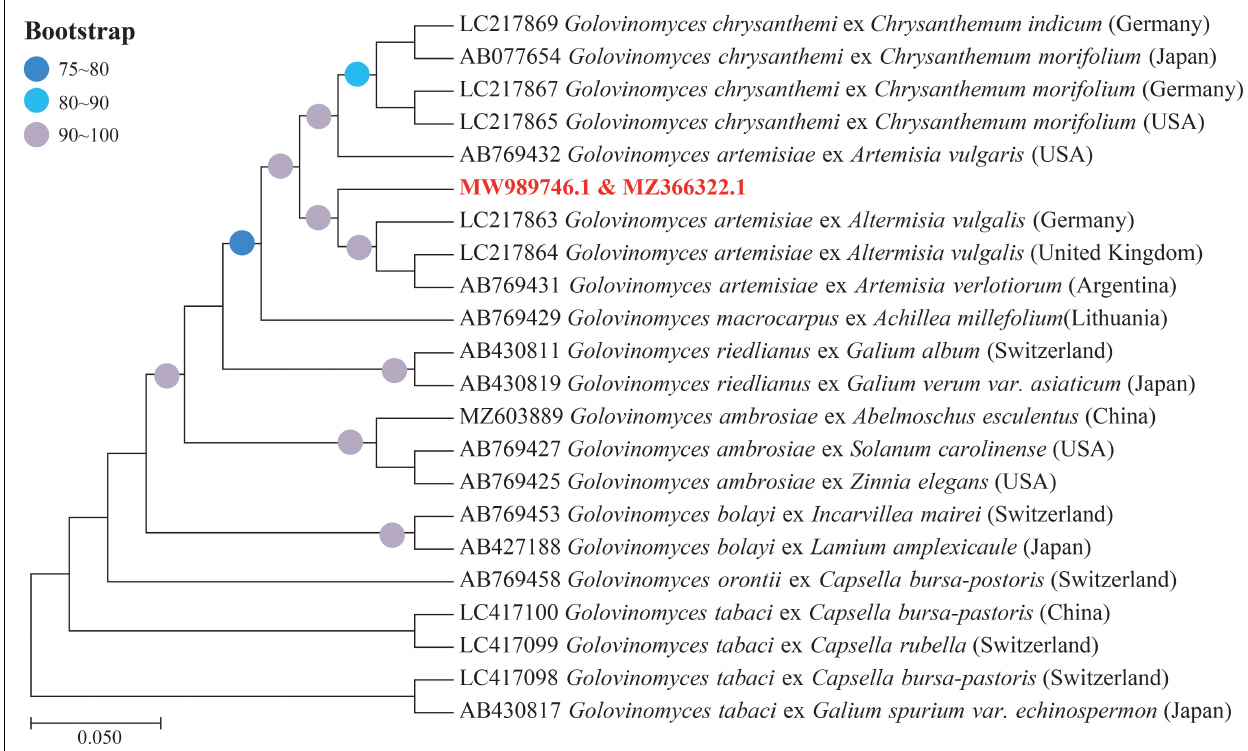
FIGURE 4 | Phylogenetic tree based on the internal transcribed spacer (ITS) and 28S ribosomal DNA (rDNA) sequences of Golovinomyces spp. derived from different plant species shows the relationship among strains of several powdery mildew (PM) species, by means of the maximum likelihood (ML) method. Bootstrap values based on 1,000 replications ( ≥ 75%) are shown above branches. The identified sequences in this study are indicated by the text in bold, red font